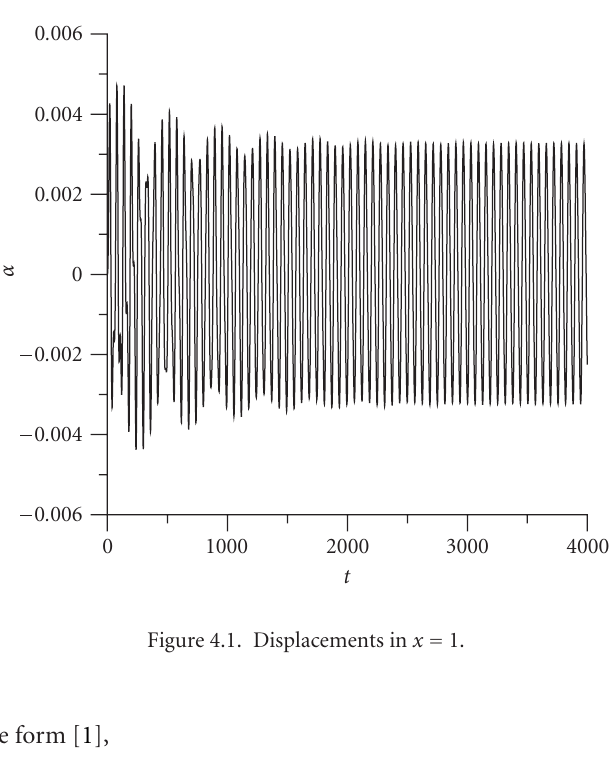
Figure 4.1. Displacements in x =